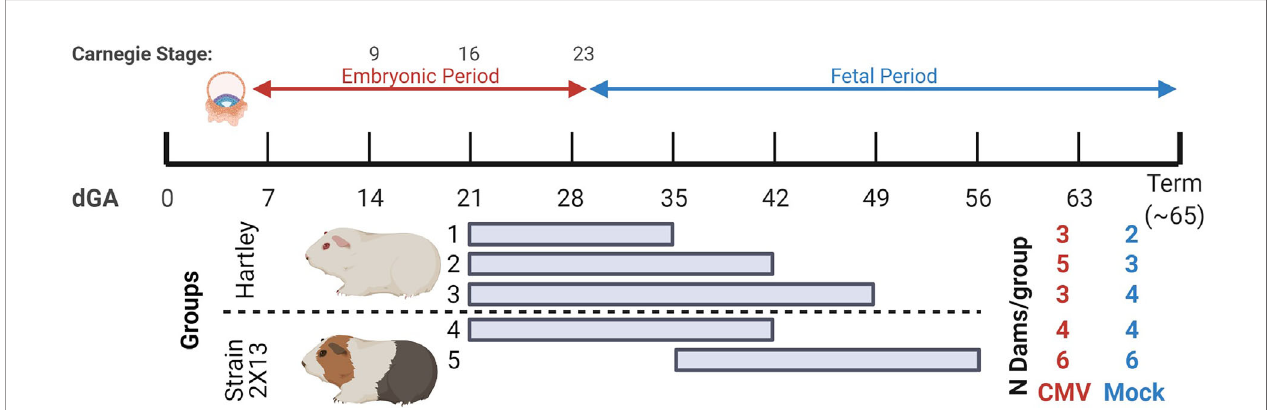
FIGURE 1 | Summary of GPCMV infections in time mated guinea pigs. The ~65-day gestational period of guinea pigs is diagramed. Implantation occurs at 5-6 dGA and the embryonic period ends at 29 dGA. Reference Carnegie stages for guinea pig development are indicated (64). Five groups of GPCMV-infected and control guinea pigs were used in this study, including outbred Hartley guinea pigs and inbred strain 2 females that were bred to strain 13 males (producing semi-allogenic, hybrid pregnancies). Guinea pigs were infected either at 21 dGA (embryonic period) or at 35 dGA (fetal period). The number of GPCMV- and mock-infected dams for each group is shown. Figure created with